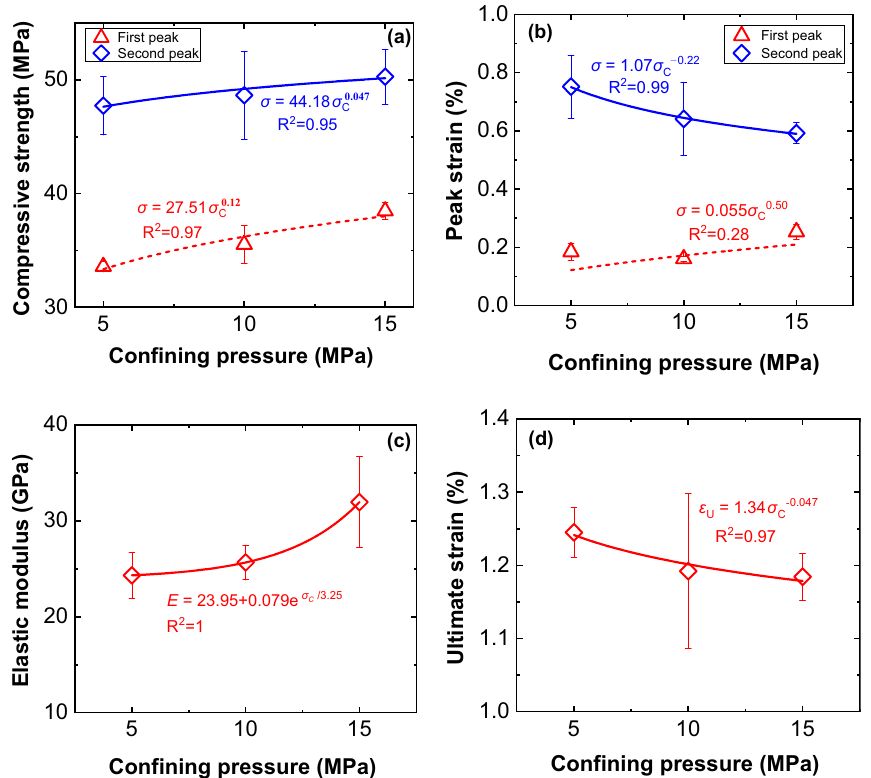
Figure 18. Histogram of mechanical parameters of combined bodies with confining pressure under high strain rate. ( a ) compressive strength, ( b ) peak strain, ( c ) elastic modulus, ( d ) ultimate